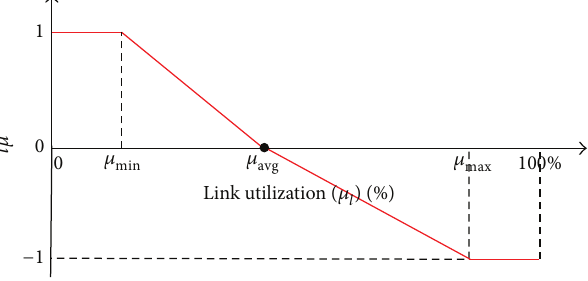
Figure 4: Membership function 𝑏 𝑝 .